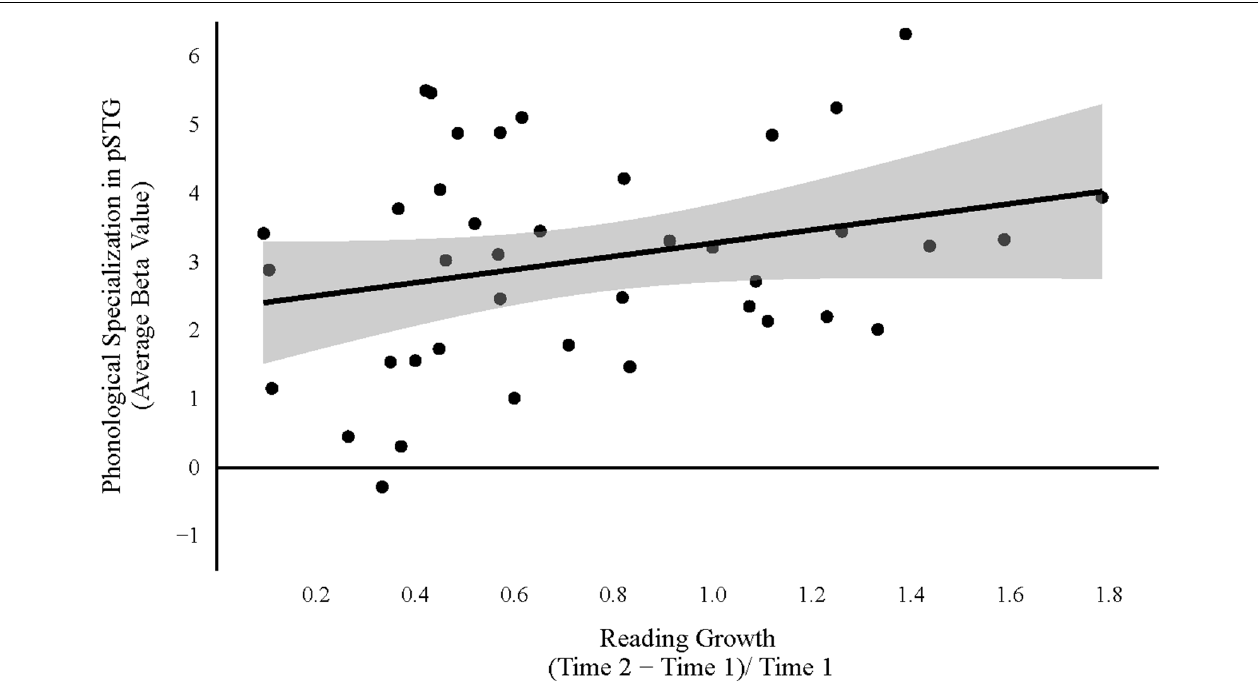
FIGURE 2 | Relation between phonological neural specialization [(Onset and Rhyme) − Control > (High and Low) − Control] in posterior superior temporal gyrus (pSTG) at 5-to-6 years old (Time 1) and growth in reading skill from 5-to-6 years old to 7-to-8 years (Time 2). The shaded region depicts a 95% confidence interval.